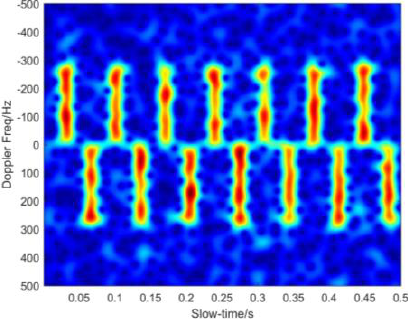
Figure 12. The TFD of the raw echo. Table 3. The standard frequency dictionary in this experiment.